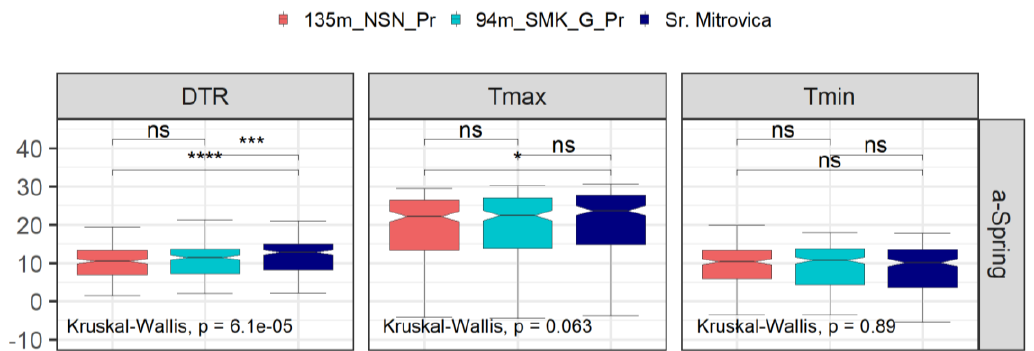
Figure 6. T max , T min , and DTR measured on the AWSs located in the pear orchards (135m_NSN_Pr and 94_SMK_G_Pr) and climatological station Sr. Mitrovica in the R5 region during the spring 2018 (sample size 90) (all years are in Supplementary S1, Figures S1.3 and S1.4). The following convention for symbols indicates statistical significance: (not significant (ns): p > 5 × 10 −2 ), (*: p ≤ 5 × 10 −2 ), (***: p ≤ 1 × 10 −3 ), (****: p ≤ 1 × 10 −4 ).